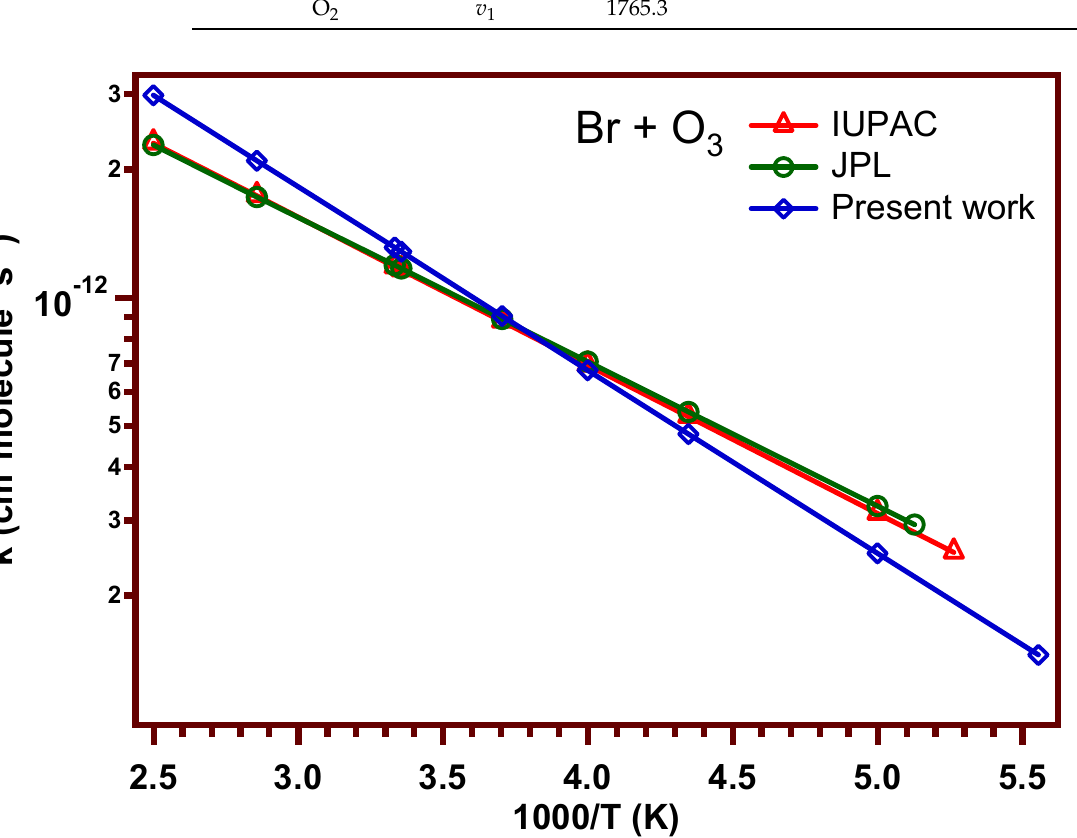
Figure 4. Arrhenius plot for the reaction of O 3 with Br obtained at the MRCI + Q/aug-ano-RCC-VTZP//MP2/aug-cc-pV(T + d)Z levels of theory using CVT/SCT rate coefficients in the temperature range of 180 and 400 K along with the recommended rate coefficients by NASA/JPL [13] and IUPAC [51].